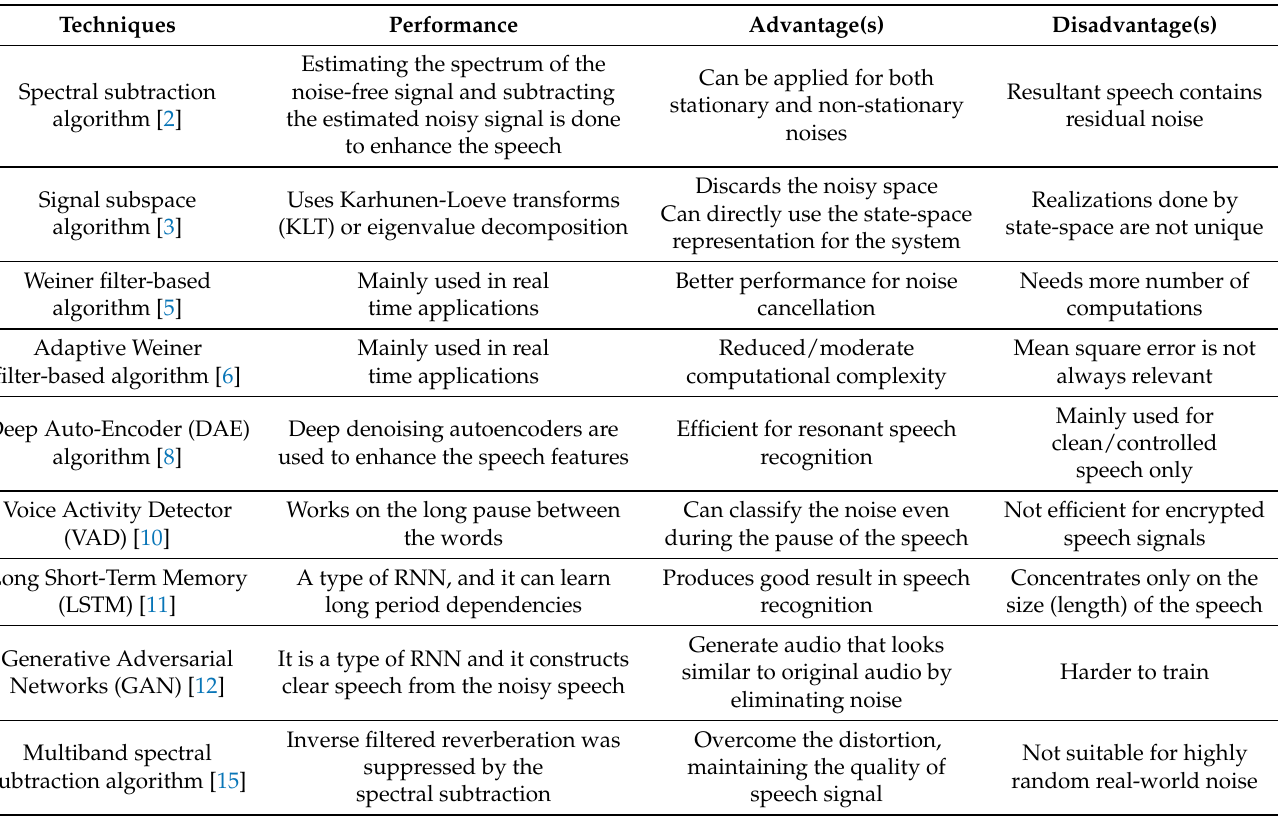
Table 1. Literature survey based on category of